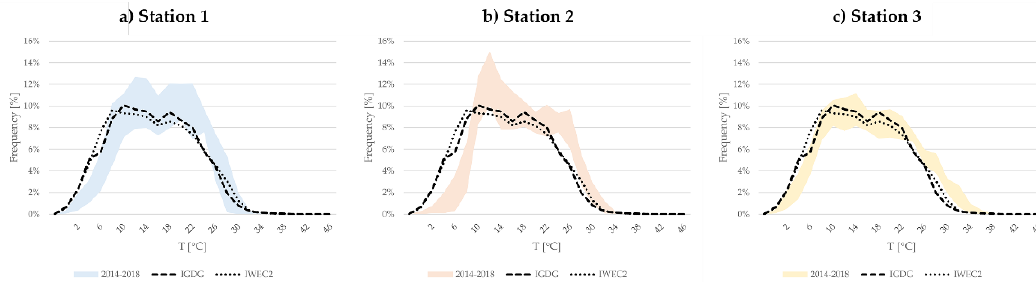
Figure 11. Frequency distribution of air temperature values recorded at stations 1, 2, and 3 and comparison with the frequency distribution of air temperatures of typical meteorological years from IGDG (1951–1970) and IWEC2 (1984–2008) databases: ( a ) frequency distribution of air temperatures at station 1, ( b ) frequency distribution of air temperatures at station 2, ( c ) frequency distribution of air temperatures at station 3.